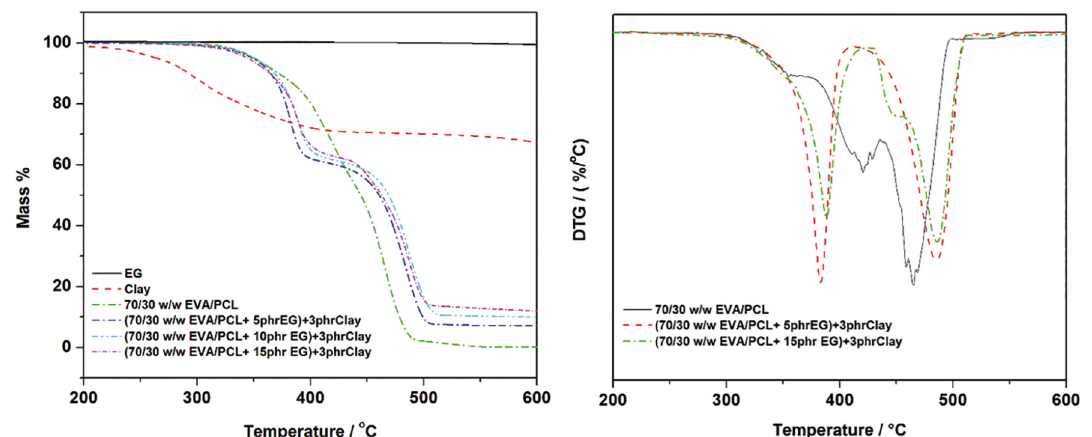
Figure 8: TGA and DTG curves of EVA/PCL blend and EVA/PCL blend with different content of EG in the presence of